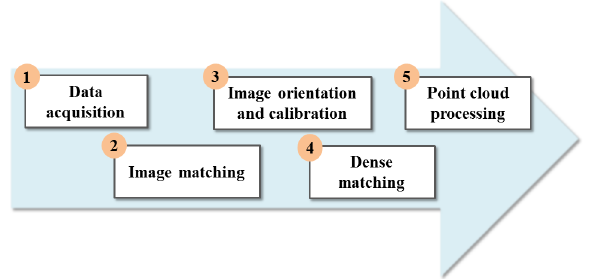
Figure 2: An overview diagram of 3D reconstruction.